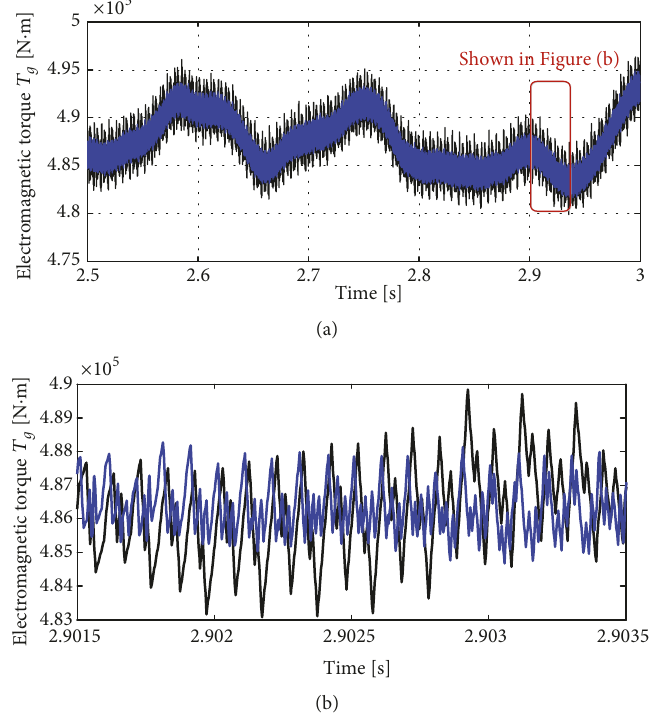
Figure 6: Electromagnetic torque curve.